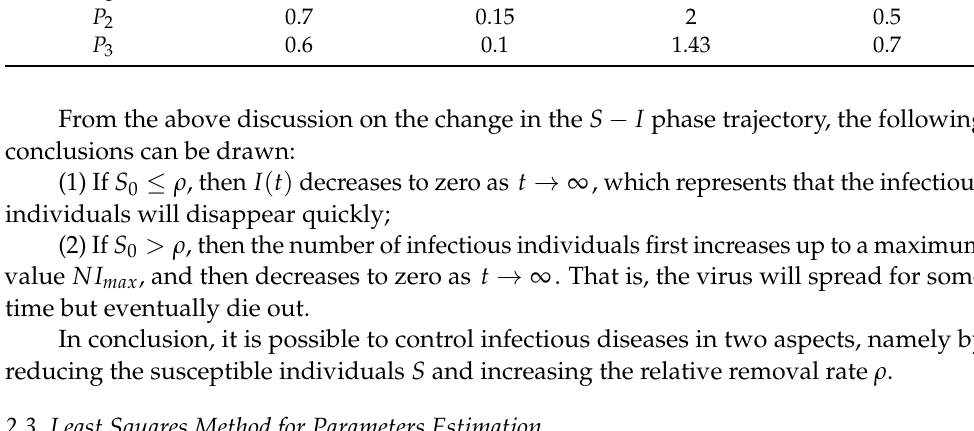
Table 1. Parameter values of each phase track.